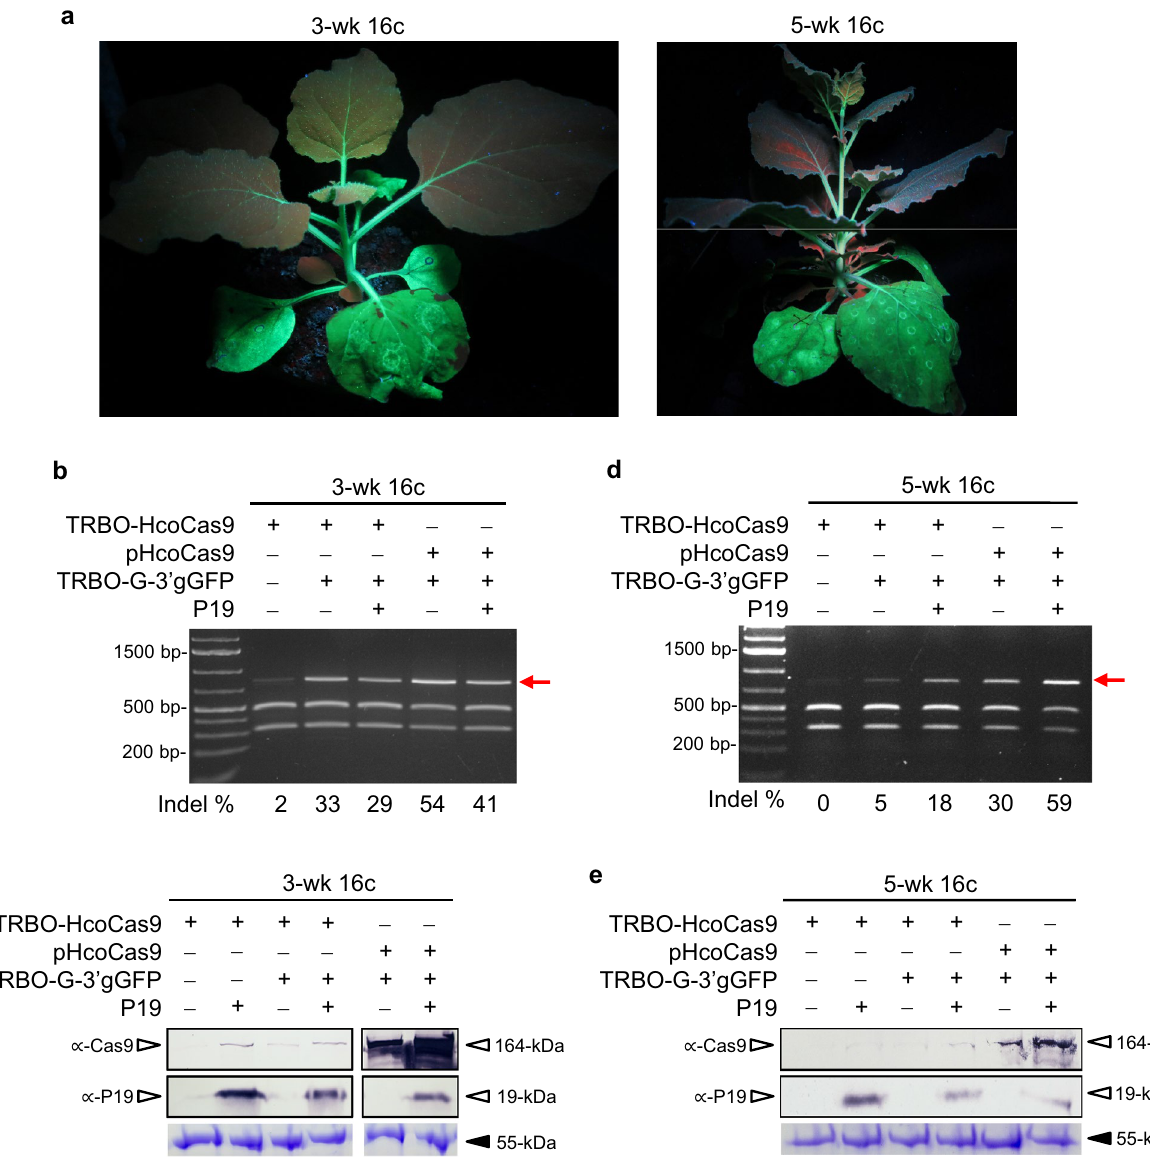
Figure 5. P19 effect on indel formation in Cas9/sgRNA infiltrated plants of different ages. ( a ) Photos of 16c plants infiltrated with TRBO-HcoCas9 and TRBO-G-3 ′ gGFP at the age of 3 weeks (3-wk) or 5 weeks (5-wk) taken at 10 dpi. (b,d) Bsg I restriction enzyme resistance assays of 3-wk-old and 5-wk-old 16c plants, respectively, co-infiltrated with either TRBO-HcoCas9 or pHcoCas9 expression constructs both with and without P19 and/or TRBO-G-3 ′ gGFP. At 10 dpi samples were taken from 16c plants that were treated either at the age of 3-wk or 5-wk. The red arrow indicates indel-containing DNA. The average and standard deviation (varying between ± 2.2 and ± 8) of indel percentages of 3-wk treated plants were calculated based on three independent biological replicates. However, for the 5-wk plants the compilations were more complicated and such analyses were not performed so they are only indicative of a trend and not of absolute differences. ( c,e ) Western blot showing Cas9 protein accumulation (164-kDa) corresponding to P19 protein expression (19-kDa) at 7 dpi in 3-wk and 5-wk-old infiltrated 16c